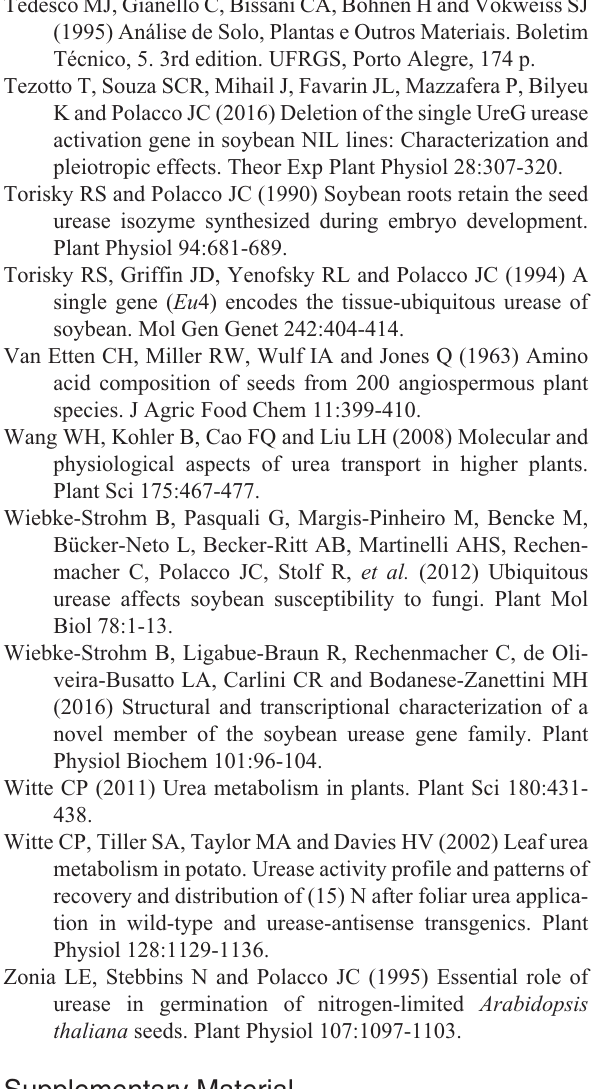
Figure S1 - Ureolytic activity in transgenic and non-trans- genic